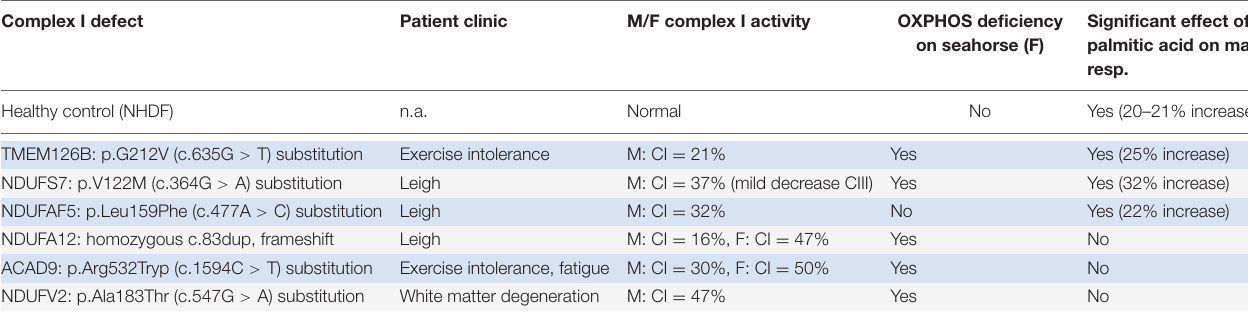
TABLE 4 | The effect of palmitic acid on respiratory capacity in patient fibroblasts with different CI defects. Complex I